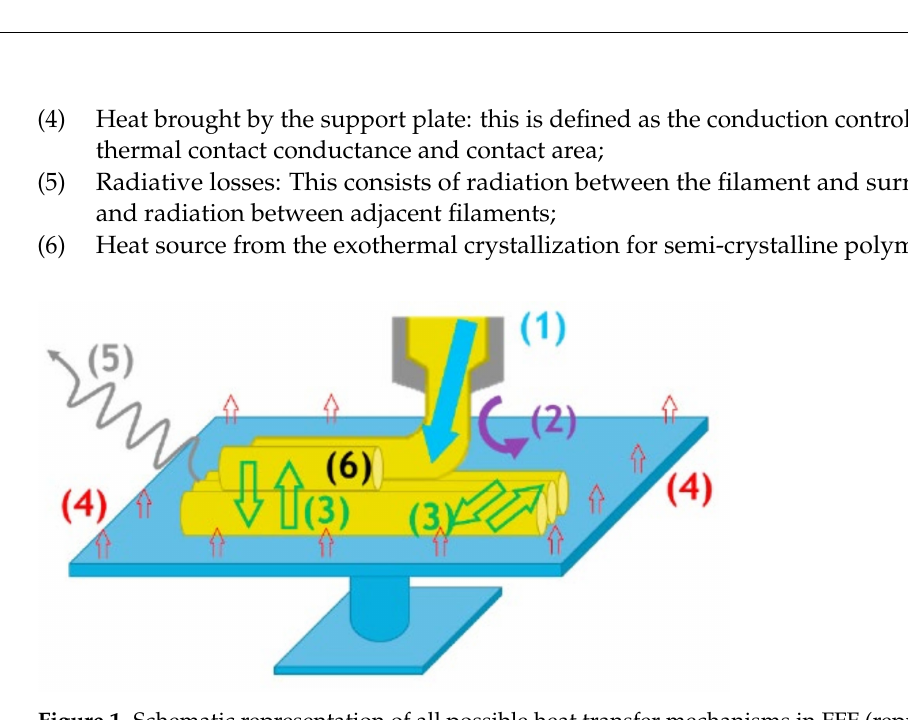
Figure 1. Schematic representation of all possible heat transfer mechanisms in FFF (reprinted with permission from